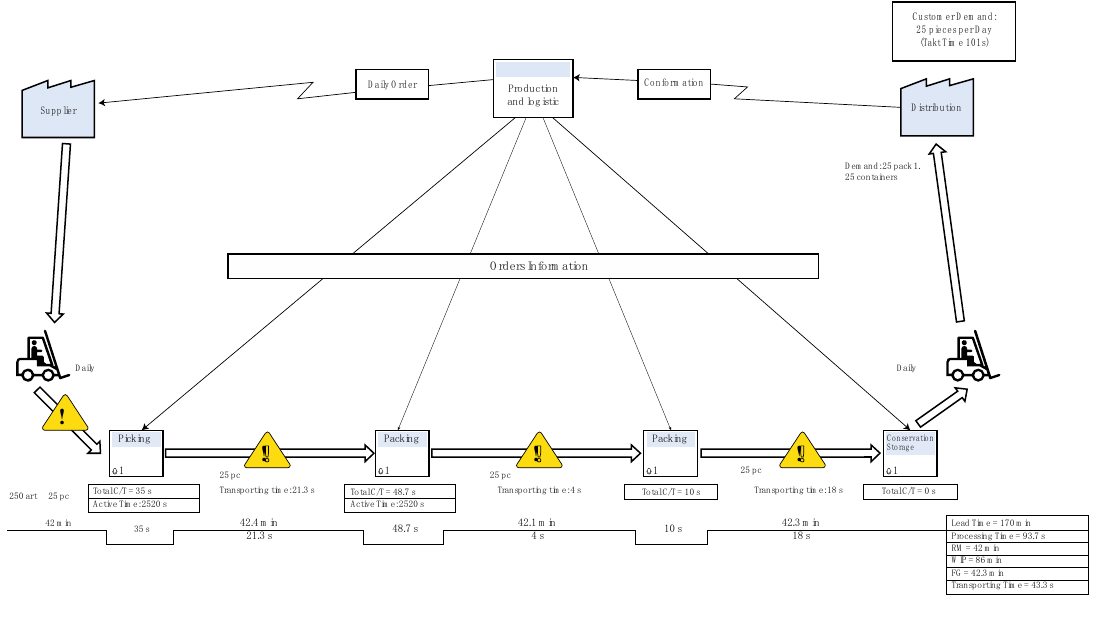
Figure 4. Current Value Stream Figure 4. Cu rrent Value Stream Map.